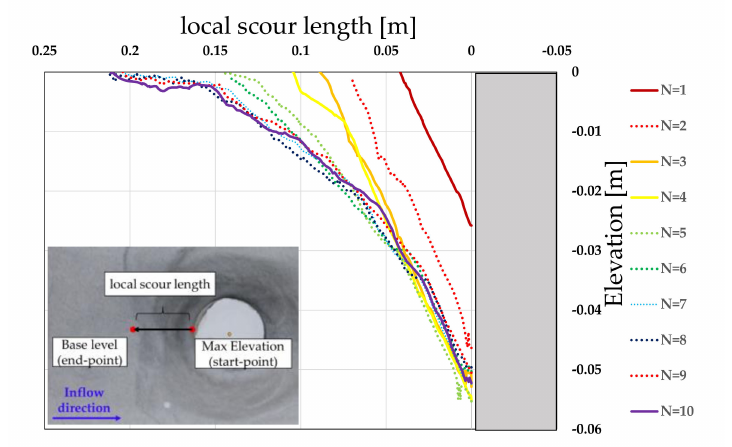
Figure 20. Cross-sectional view of local scour hole in Case 6 (point 1).